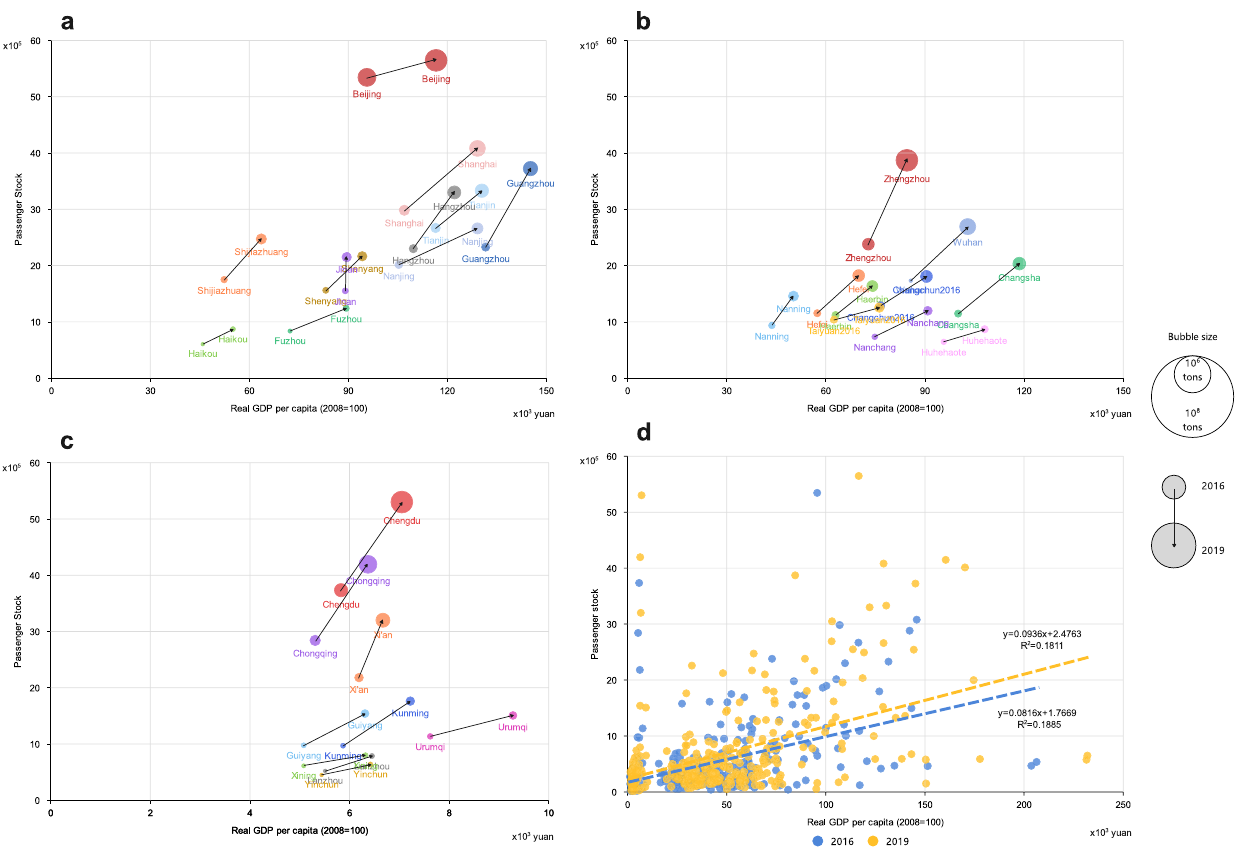
Fig. 4 Relation dynamics of road passenger stock, GDP per capita (2008 = 100), and CO 2 emissions from 2016 to 2019. a 11 provincial capitals of Eastern China; b 10 provincial capitals of Central China; c 9 provincial capitals of Western China; d relationship between passenger car stock and economic development in 291 prefecture-level cities. The two bubbles (the small and big bubble) in sub fi gures show carbon emissions in 2016 and 2019 respectively, and the size gives the number of estimated